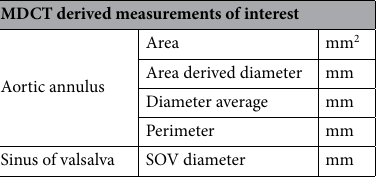
Table 1. Measured parameters using 3 Mensio for structural heart